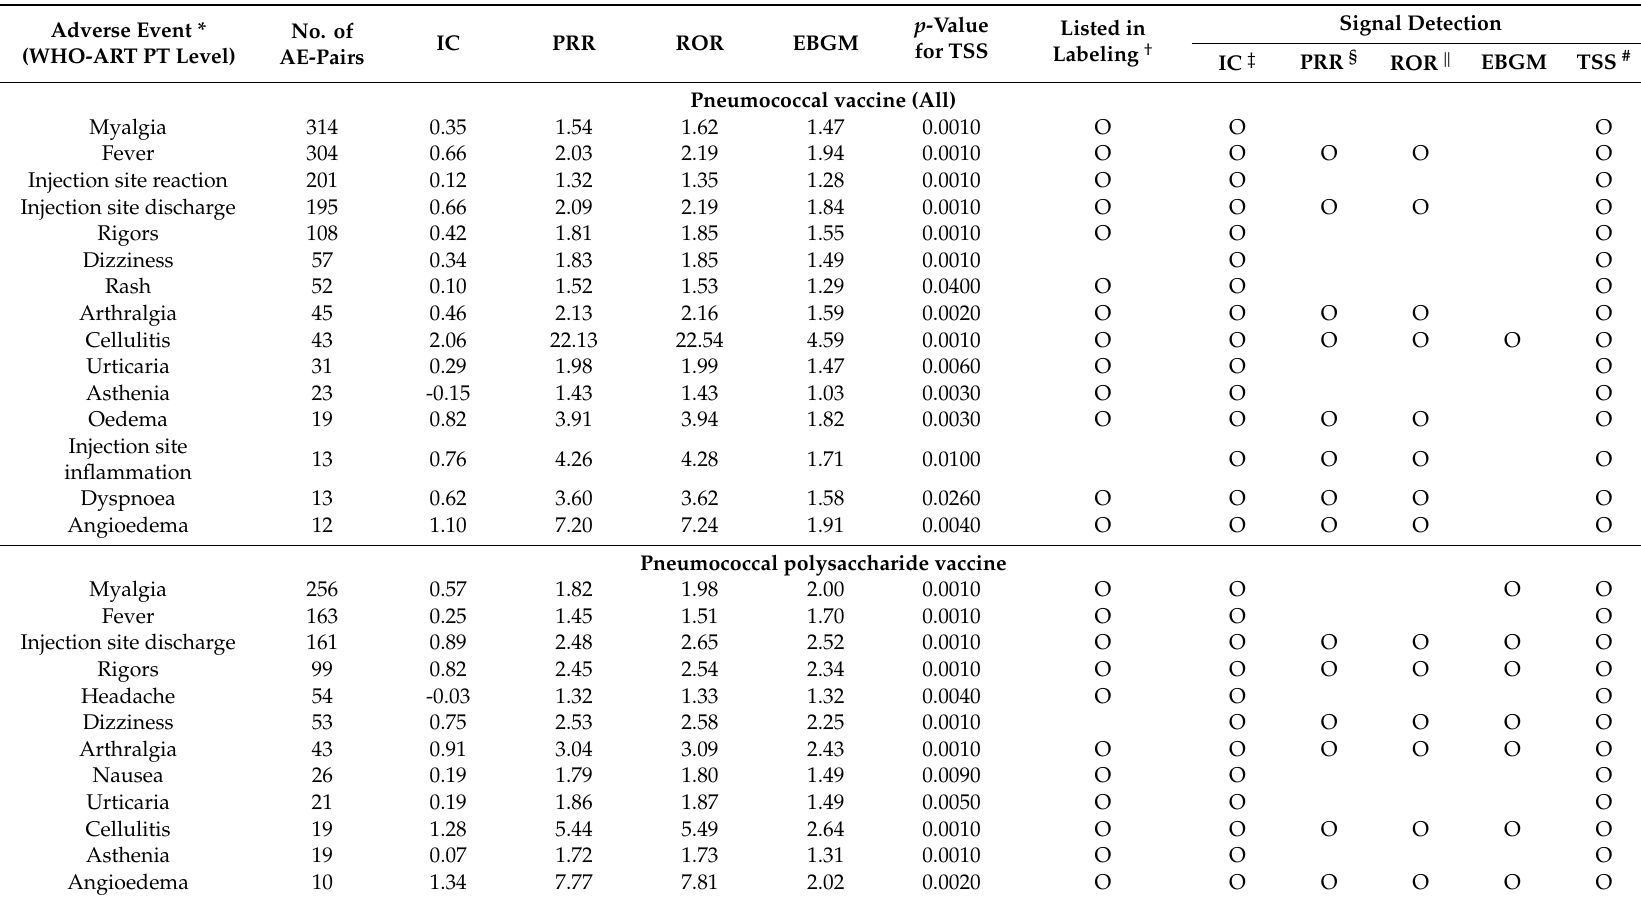
Table 3. Signal detection of pneumococcal vaccine using the disproportionality methods, empirical Bayes geometric mean, and tree-based scan statistic from 1988 to